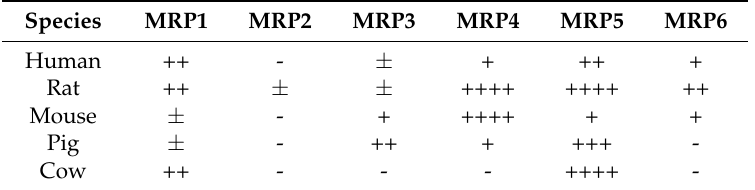
Table 1. Comparison of MRP/Mrp mRNA levels in brain microvessel endothelial cell from five species. ++++, >10% of GLUT1; +++, >4% of GLUT1; ++, >2% of GLUT1; +, >1% of GLUT1; ± , <10% of GLUT1 and -, no detected, data were derived from reference